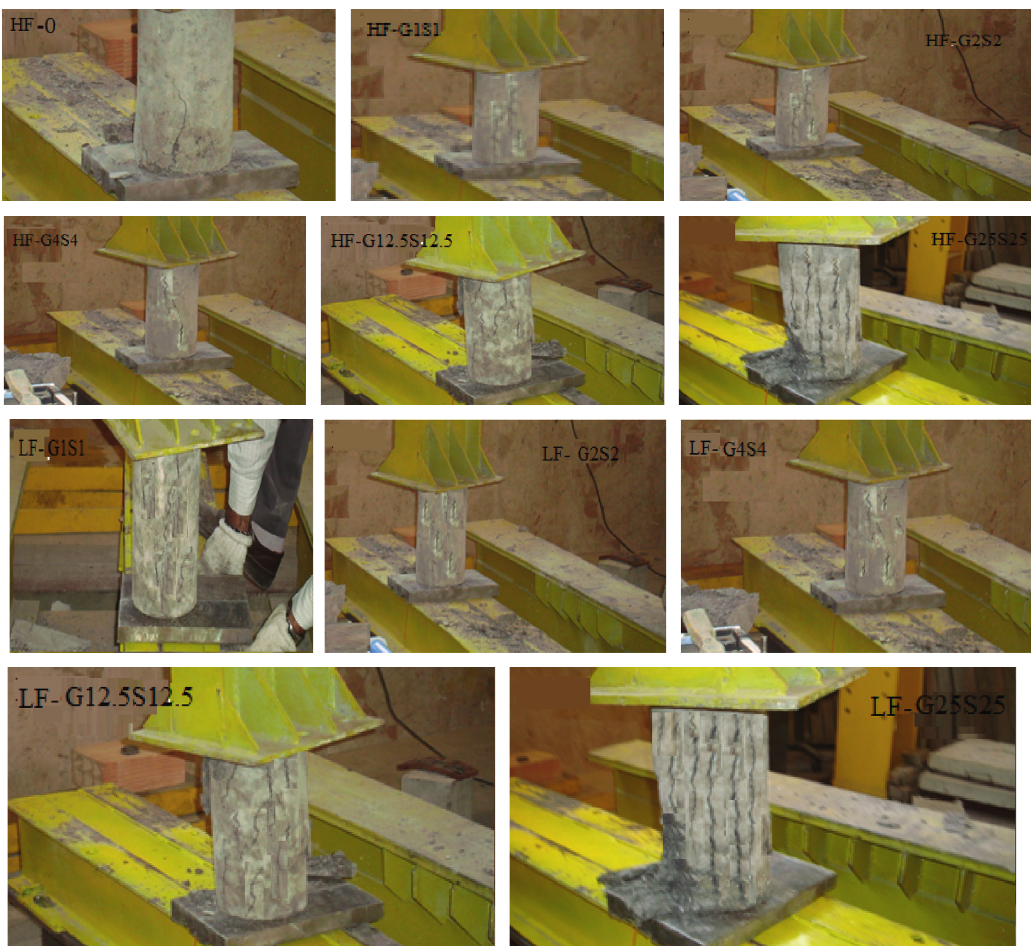
Figure 5: Stress-strain curve of HF specimens at 28 days. (a) Stress-strain diagrams of all HF specimens at 28 days. (b) Stress-strain diagrams of HF specimens with low content of silicone rubber at 28 days. (c) Stress-strain diagrams of HF specimens with a high content of silicone rubber at 28